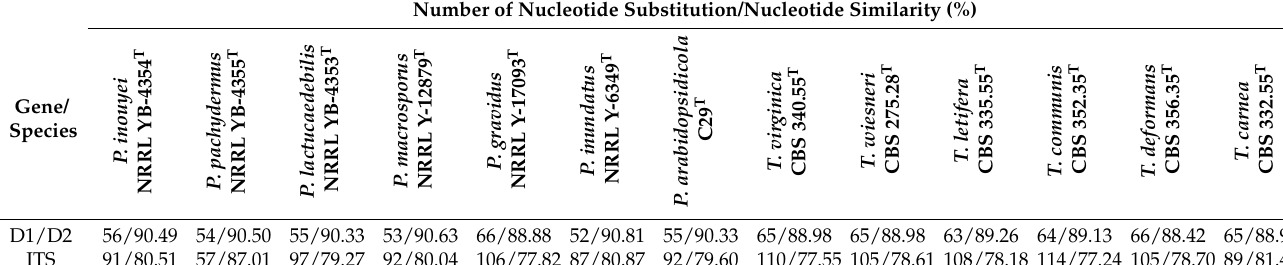
Table 3. Number of nucleotide divergent and percent of nucleotide similarity in the D1/D2 domains of the LSU rRNA gene and the ITS regions between the Savitreella phatthalungensis sp. nov. and its closely related